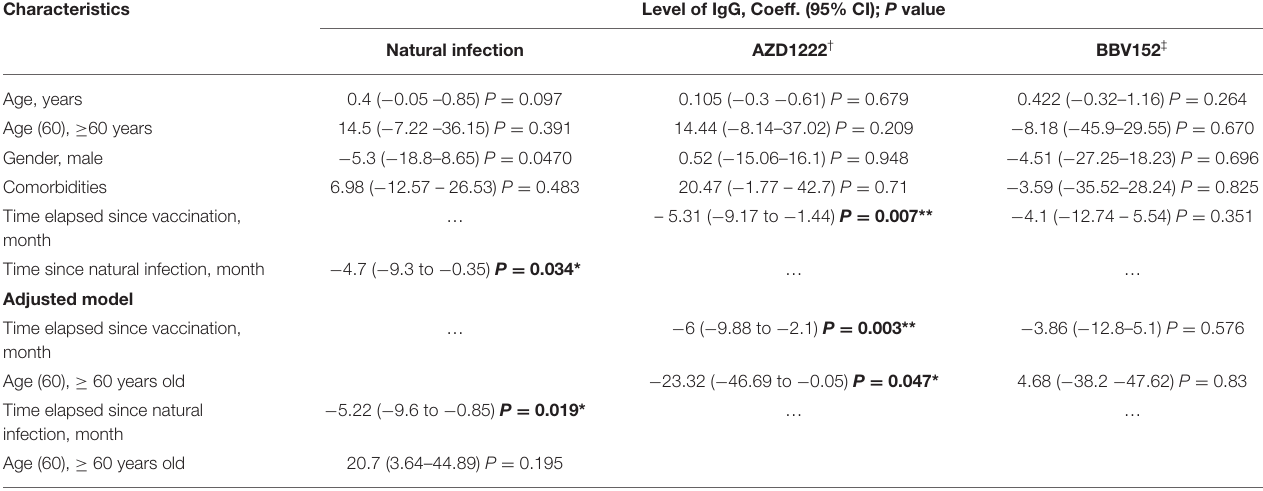
TABLE 3 | Factors associated with decay of anti-SARS-CoV-2 S1 IgG levels.